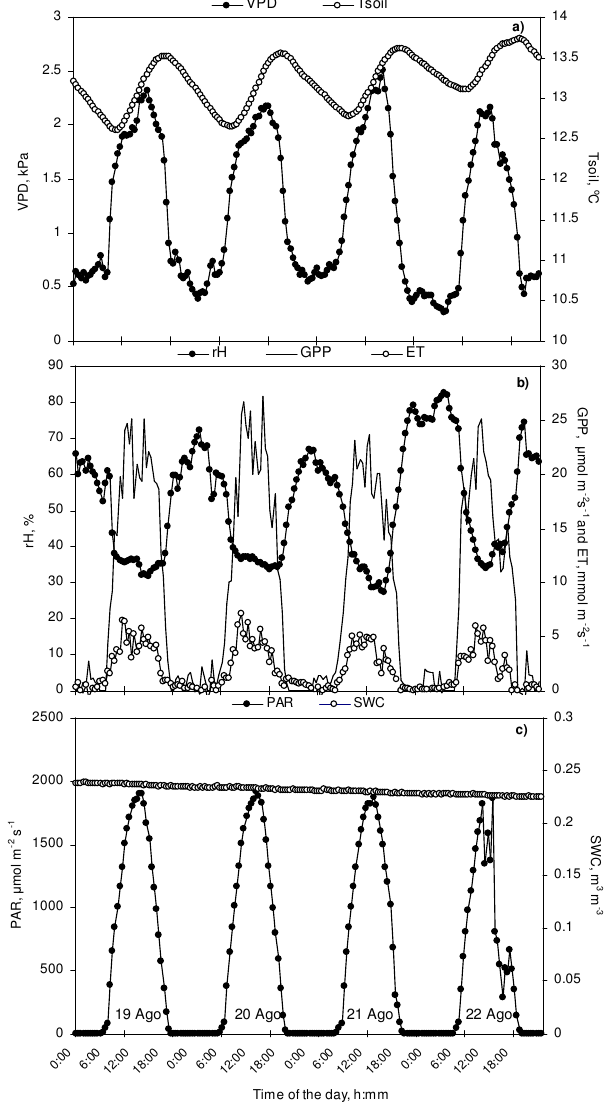
Fig. 1. Variation in (a) vapour pressure deficit (VPD, kPa) and soil temperature (Tsoil, ◦ C) (b) gross primary production (GPP, µmolm − 2 s − 1 ) , evapotranspiration (ET, mmolm − 2 s − 1 ) and air relative humidity (RH, %) (c) soil water content (SWC, m 3 m − 3 ) and photosynthetic active radiation (PAR, µmolm − 2 s − 1 ) measured on the day before and during three days of sampling. VPD was cal- culated for 25m height, PAR was measured at 27m height, and GPP and ET – 10m above the canopy, Tsoil and SWC correspond to a depth of